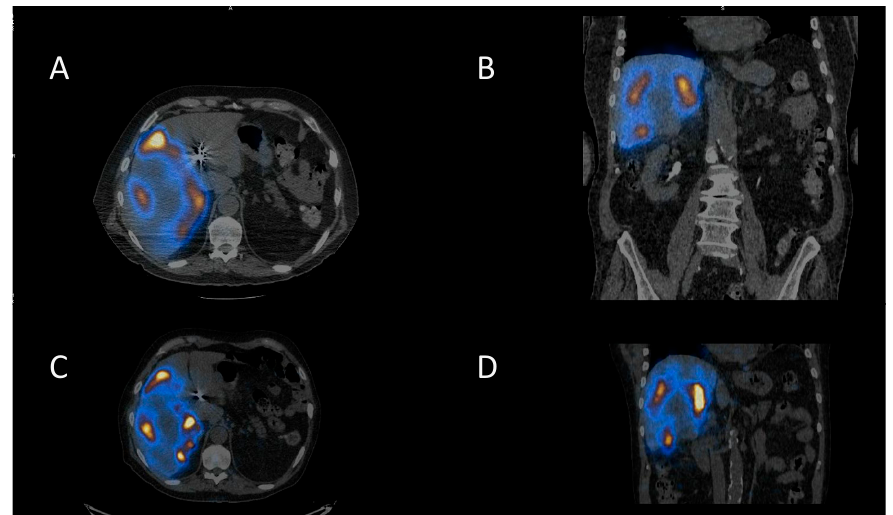
Figure 3. Selective internal radiotherapy with radiolabelled microspheres for liver metastases. ( A ) Axial and ( B ) coronal fused SPECT CT images of 99m Tc-MAA (macroaggregated albumin) pre-treatment imaging for dose calculation and treatment verification. Corresponding ( C ) axial and ( D ) coronal post-therapy PET CT images following therapy with 90